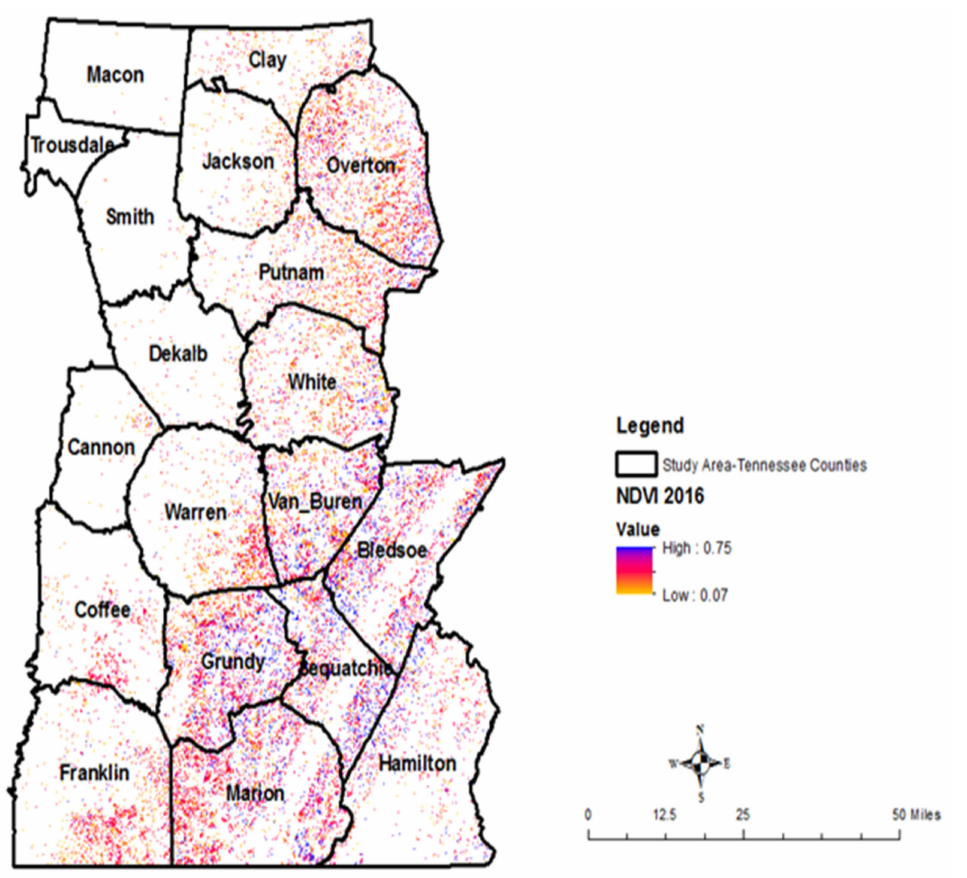
Figure 8. February 2016 NDVI of southern yellow